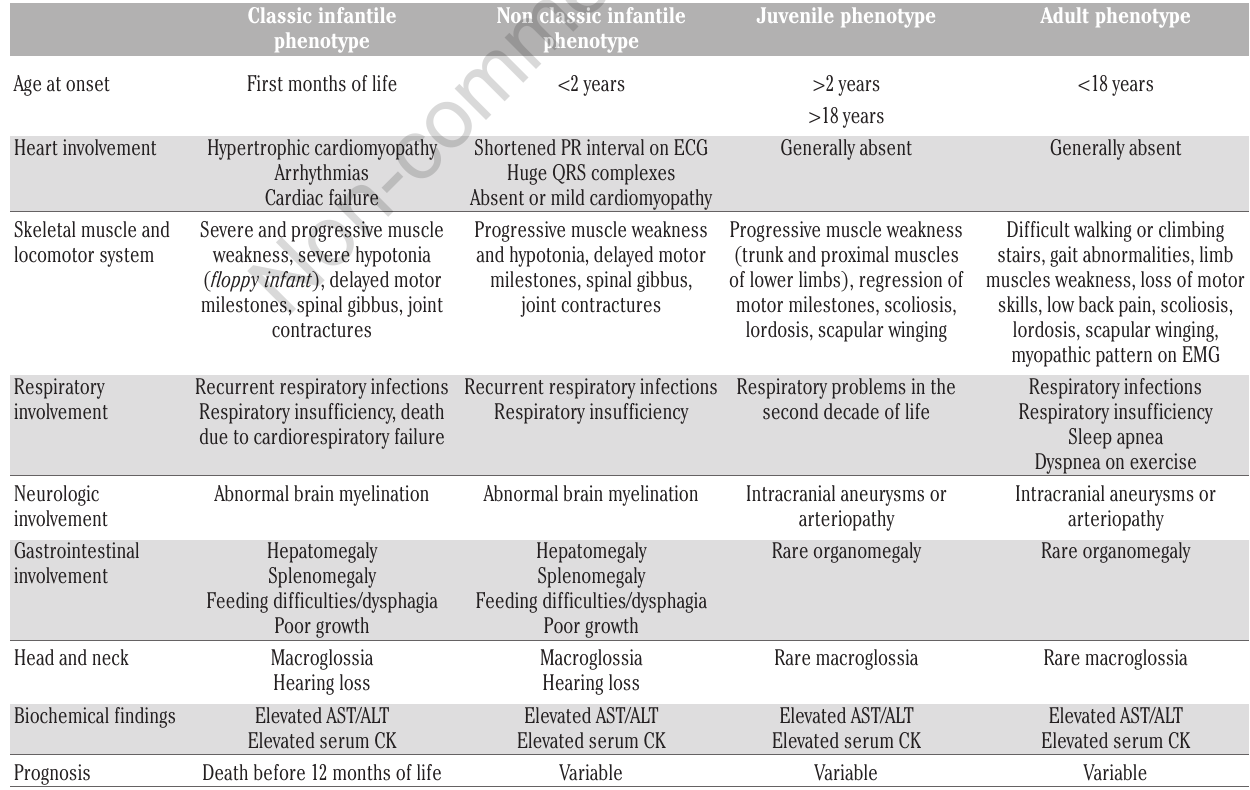
Table 1. Main clinical features in different age-related